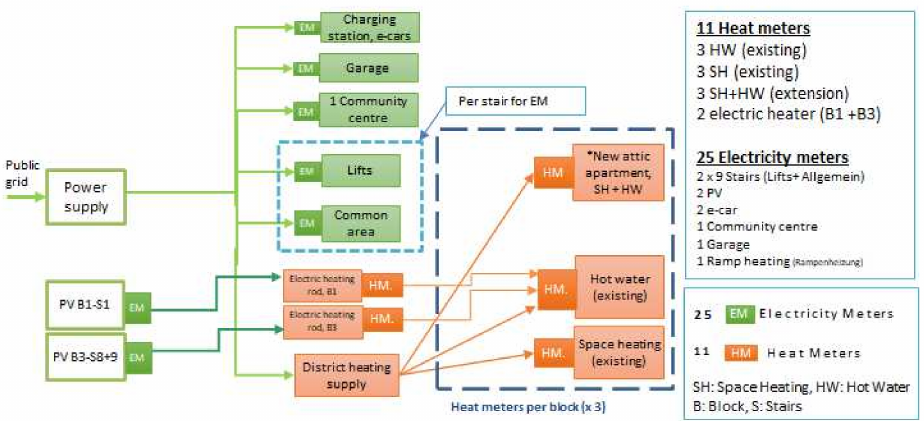
Figure 7. Schematic monitoring setup of the building complex of Hauffgasse, Vienna demonstration site.